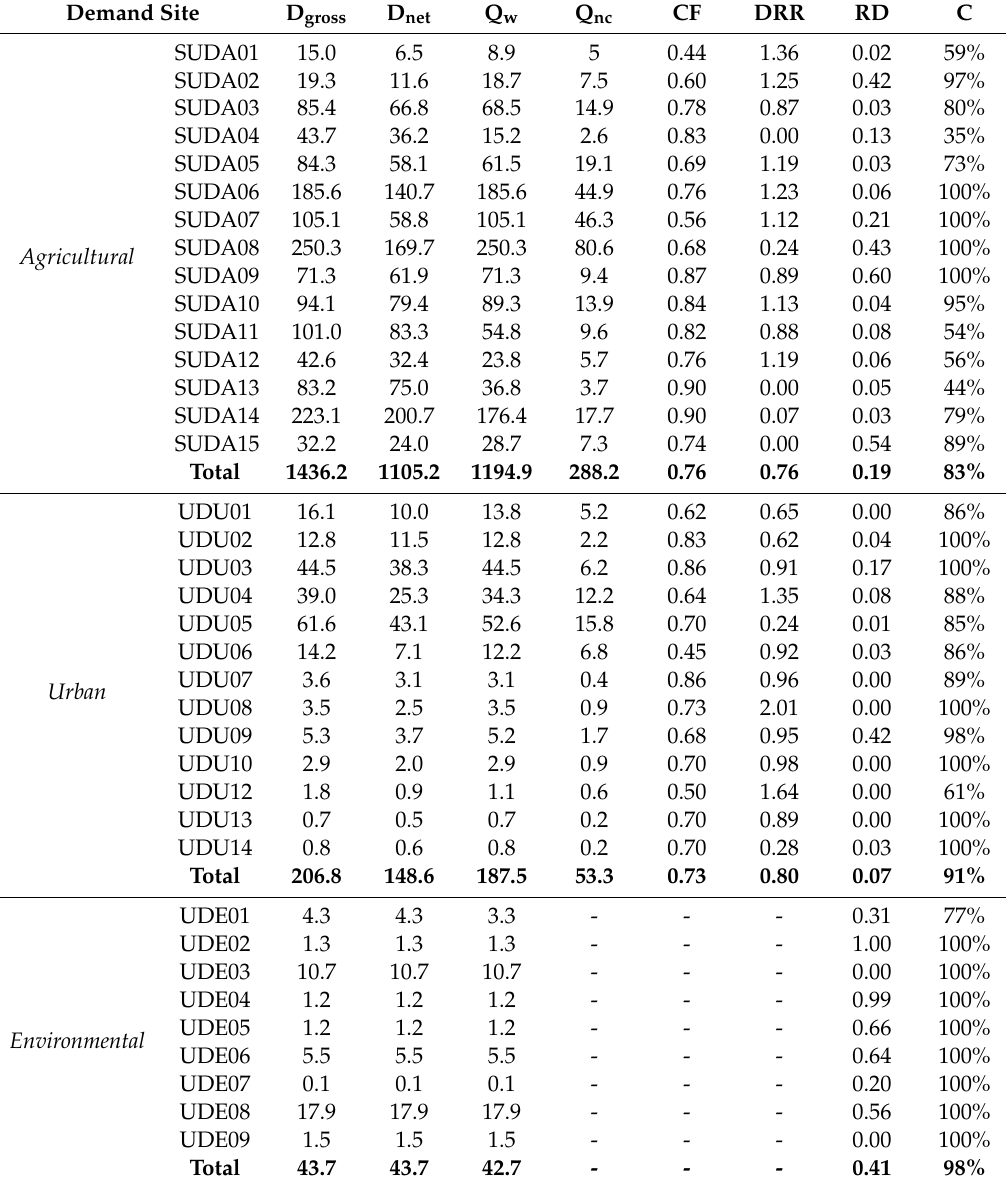
Table 3. Demand, supply, return flow, and water reuse indicators calculated at the demand site level. D gross = gross demand (hm 3 / year), D net = net demand (hm 3 / year), Q w = total withdrawal (hm 3 / year), Q nc = return flow (hm 3 / year), CF = Consumed Fraction (-), DRR = Degree of Return flow Reuse (-), RD = Reuse Dependency (-), C = Coverage